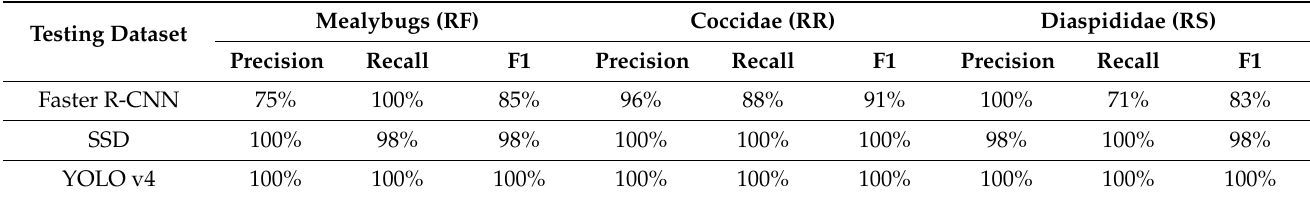
Table 1. Statistical indicators for scale detection.